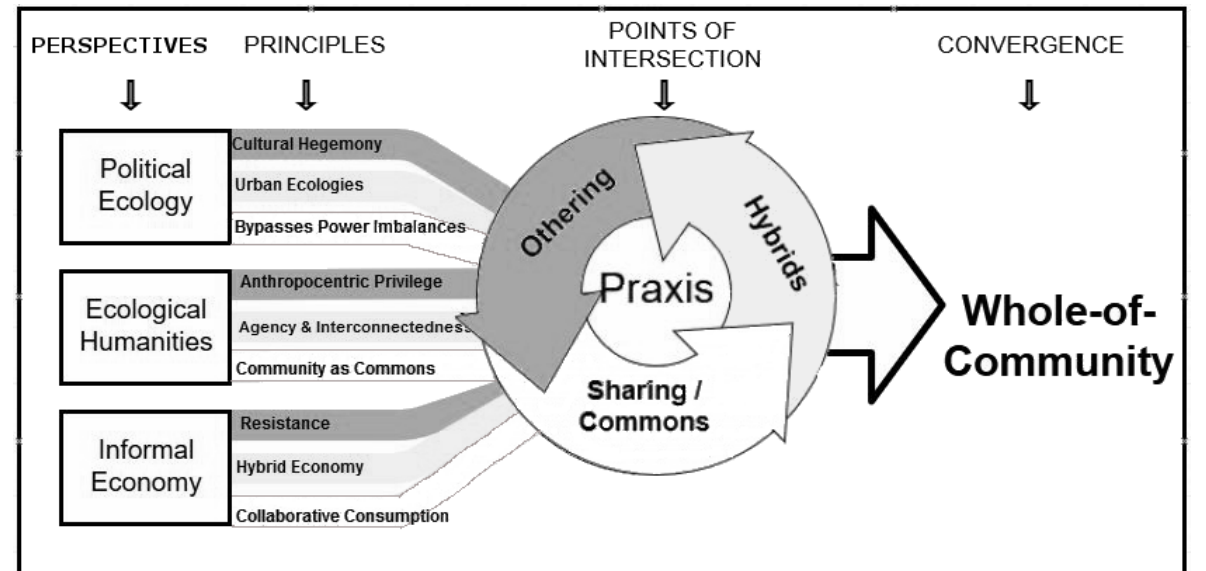
Figure 2. Conceptual Model of the Convergence of